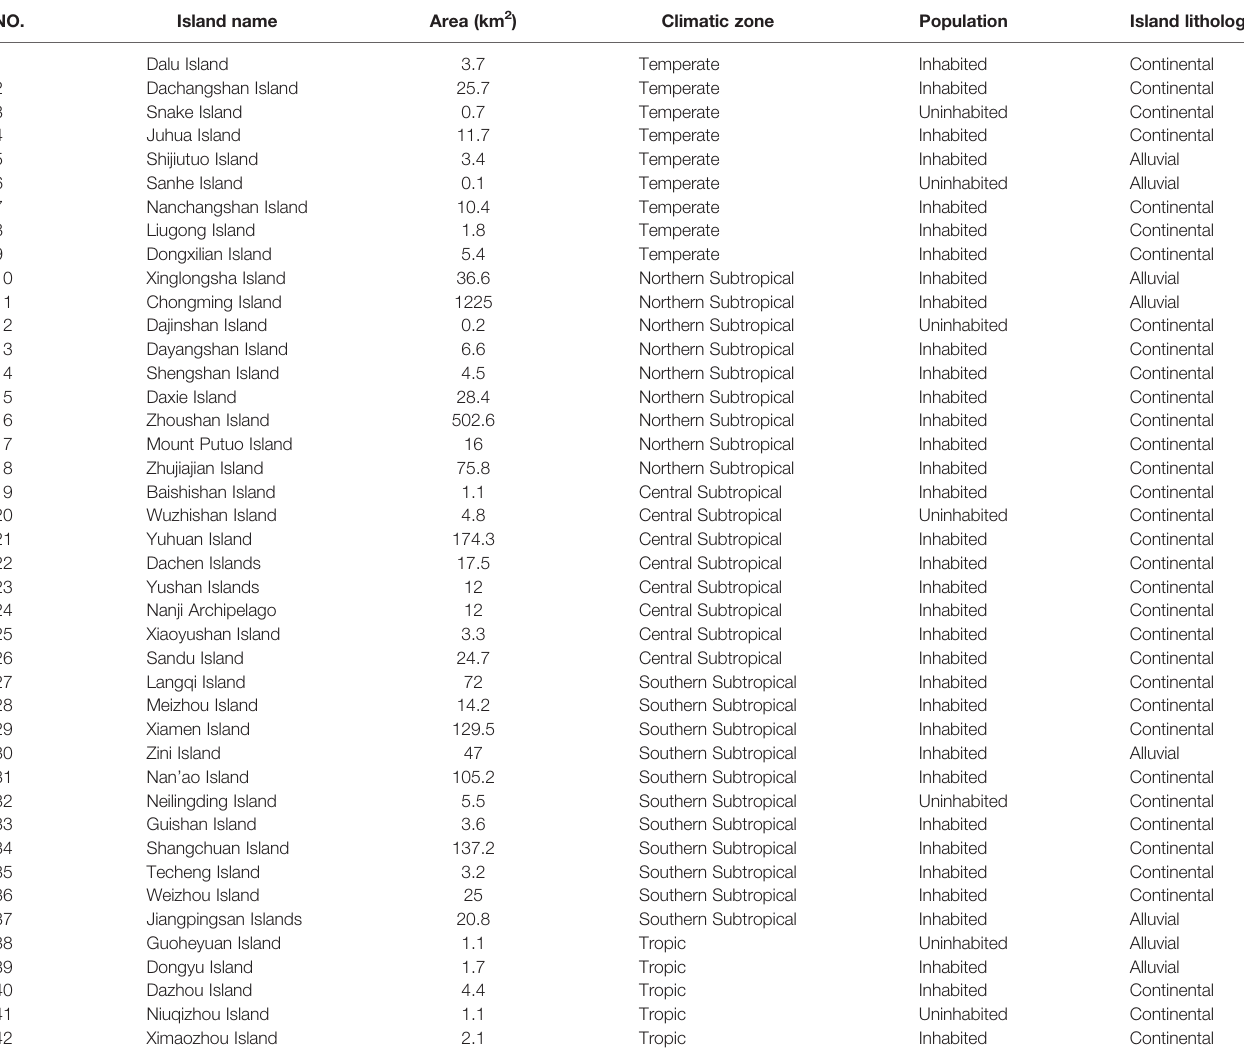
TABLE 1 | Characteristics of the selected islands in this study.